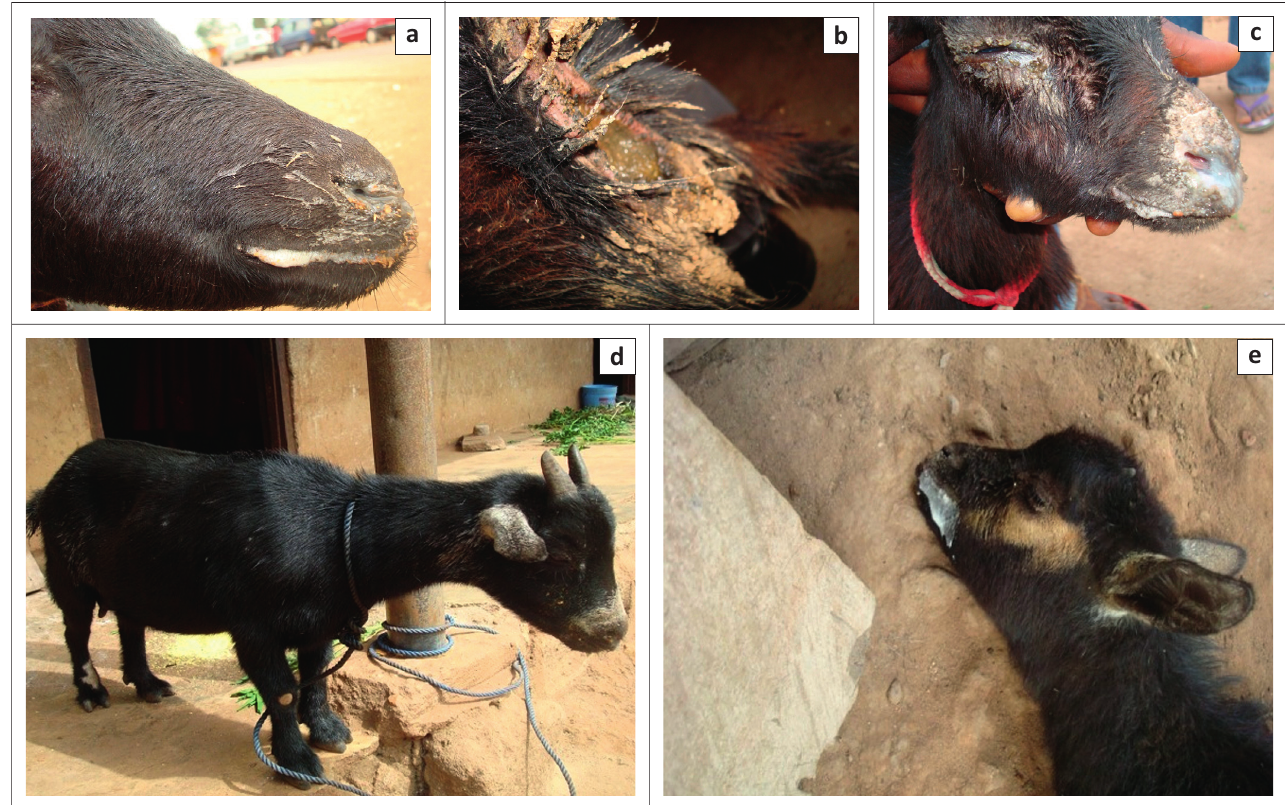
FIGURE 1: Clinical signs (compatible with Peste des petits ruminants) observed during sampling (2010–2013) in various locations in Nigeria: (a) frothy salivation and muco-purulent nasal discharge; (b) soiled anal region because of profuse diarrhoea; (c) matted eyelids, salivation and nasal discharges; (d) raised hair coat, depression and increased rectal temperature and (e) frothy salivation and